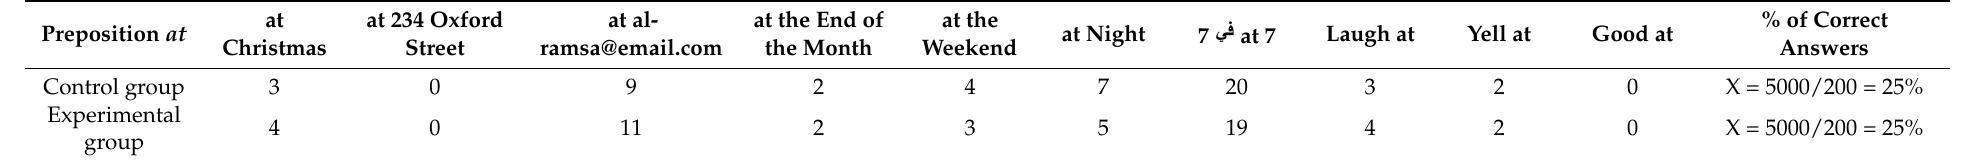
Table 4. Pretest for the preposition at . Table 8. Posttest 1 of the preposition at .